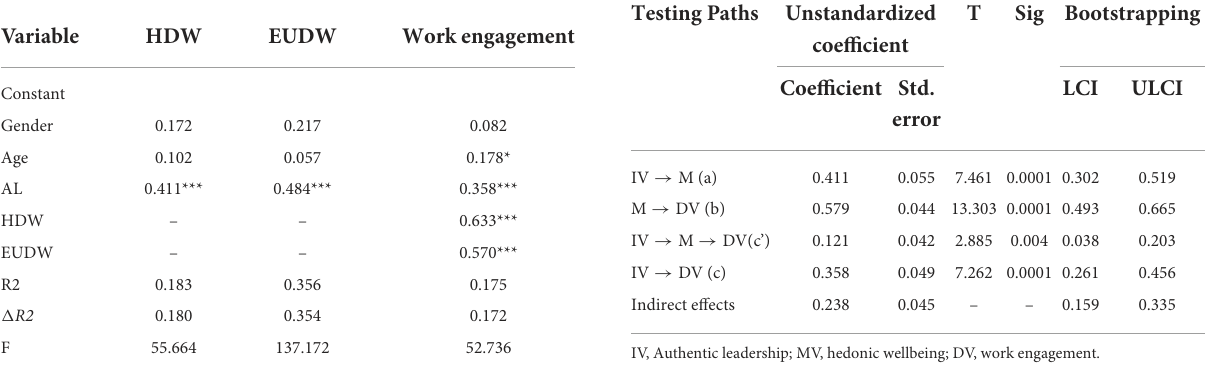
TABLE 4 Coefficient and bootstrapping for the mediation